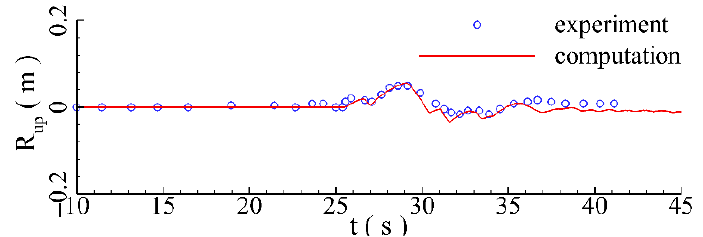
Figure 3. Time series of the wave runup height.